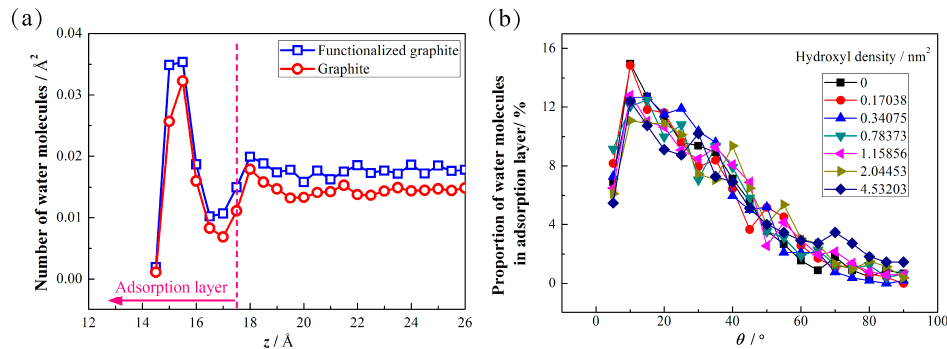
Figure 3. Distribution of water molecules along the z -direction. ( a ) Number density of water molecules in two different systems; ( b ) Proportion of water molecules in adsorption layer with different θ .